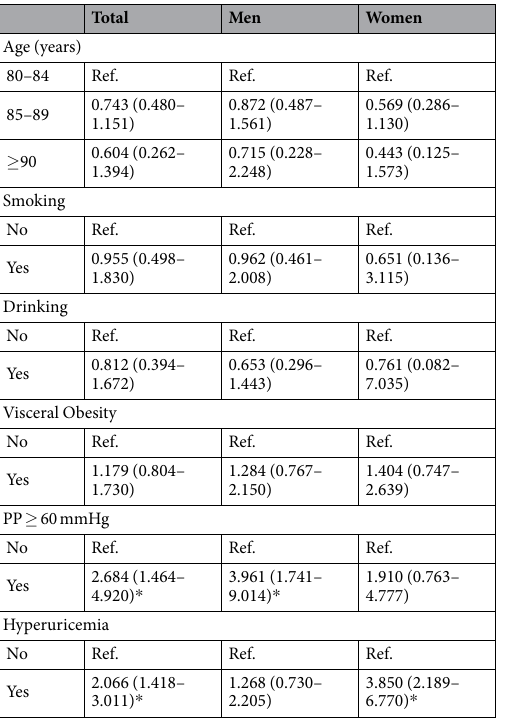
Table 4. Logistic regression results of risk factors for ≥ 3 comorbid abnormalities. Ref., reference category. Data are presented as odds ratio (95%CI). CI = confidence interval; Hyperuricemia defined as UA ≥ 416 μ mol/L in men, UA ≥ 357 μ mol/L in women. Visceral Obesity defined as waist circumference ≥ 90 cm in men, waist circumference ≥ 85 cm in women. Comorbid abnormalities included hypertension, diabetes mellitus, renal dysfunction, and dyslipidaemia. * P < 0.05 versus reference category.